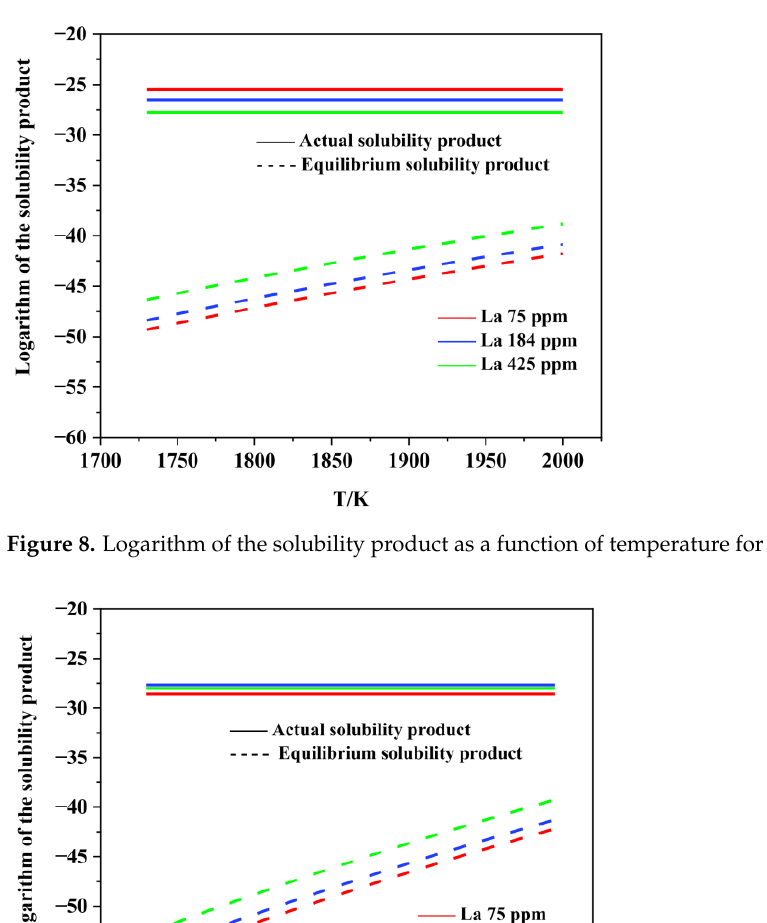
2 O 3 in liquid steel.